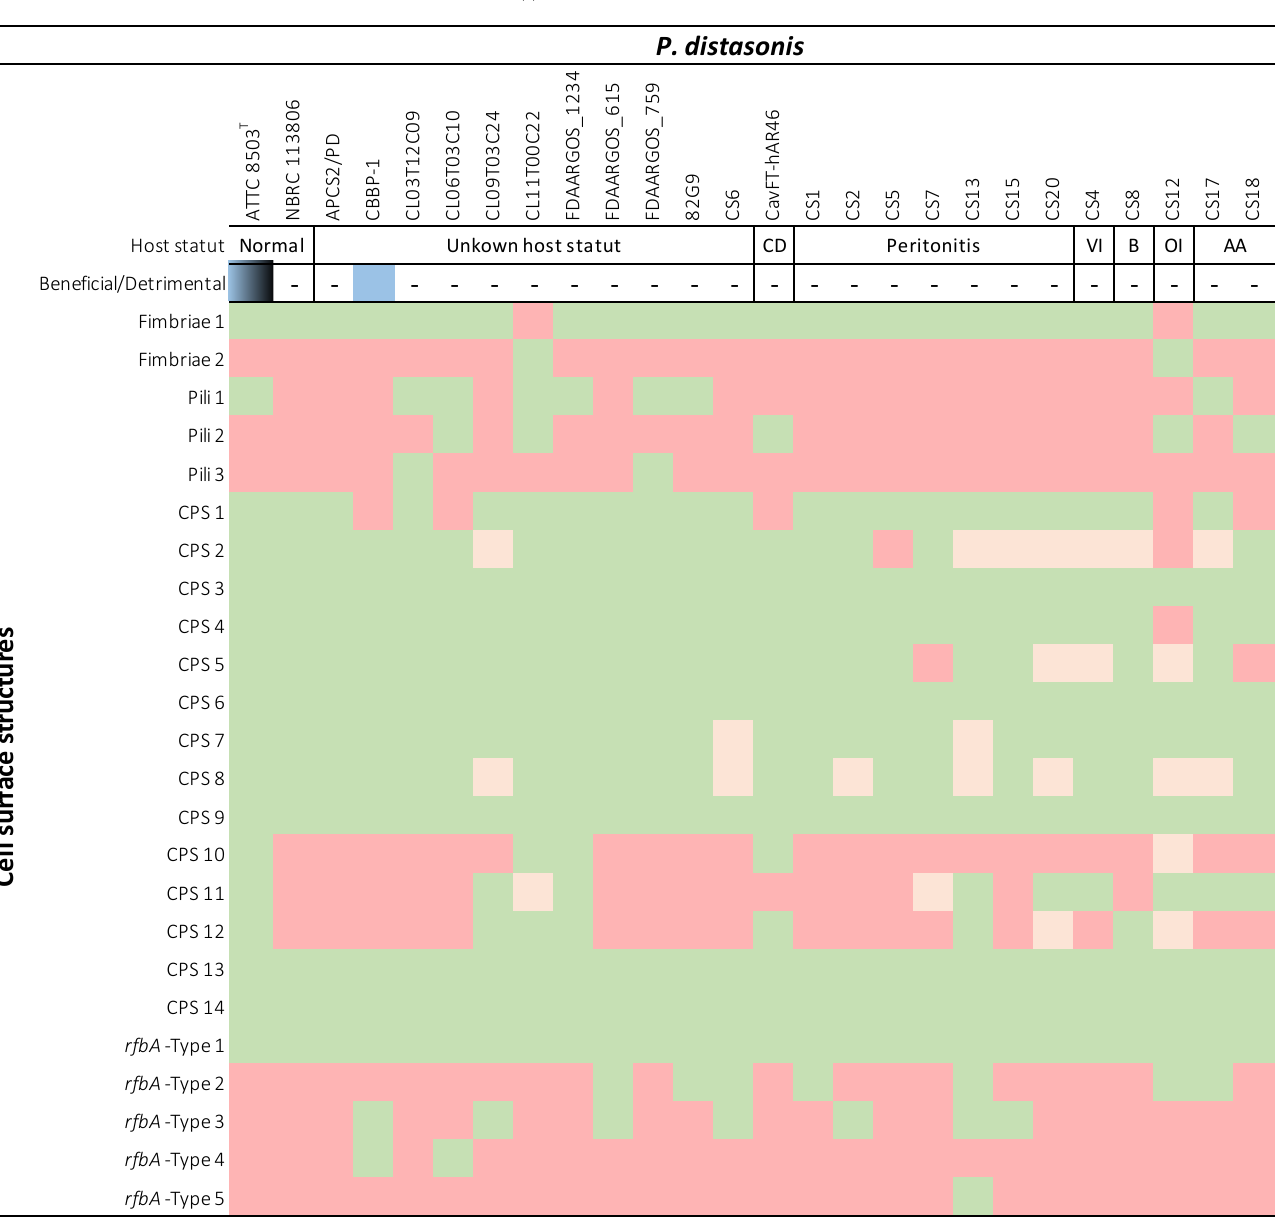
Table 4. Identification of cell surface structures present on 26 P. distasonis strains based on host status. The beneficial or detrimental activity of strains (based on the literature) was added in order to compare potential pathogen from probiotic strains. Color code: beneficial properties (blue), detrimental properties (black), presence (green), partial presence (orange), absence (red). ATCC 8503 T is represented as blue/black for its beneficial/detrimental activities due to various results found in the literature. Dashes (-) have been added for unknown